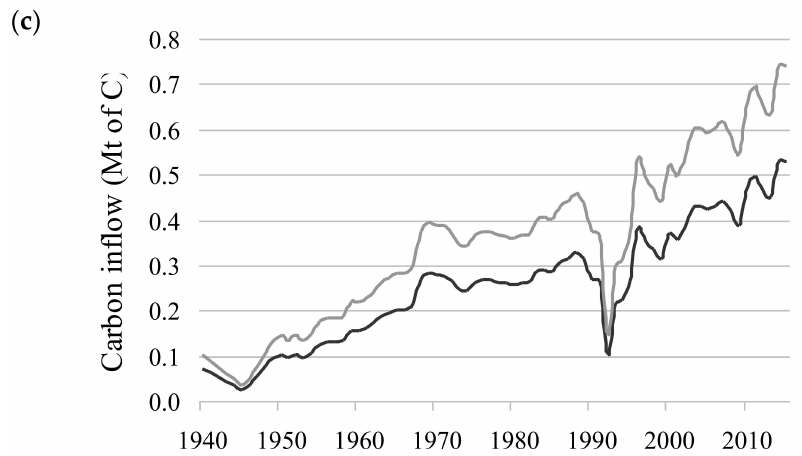
Figure 2. Historical carbon inflows by applying the IPCC Tier 2 and Tier 3 methods: ( a ) estimates based on available FAO data (1992–2015); ( b ) estimates based on available literature data (1960–1991) and FAO data (1992–2015); ( c ) estimates based on data obtained from national statistics (1940–1991) and FAO data